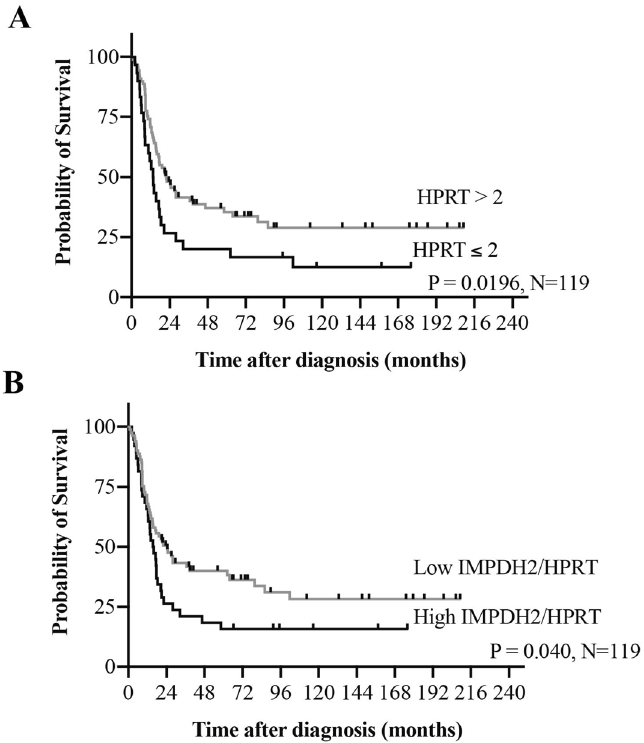
Figure 2. Kaplan–Meier curves showing overall survival by ( A ) HPRT and ( B ) IMPDH2/HPRT ratio in osteosarcoma